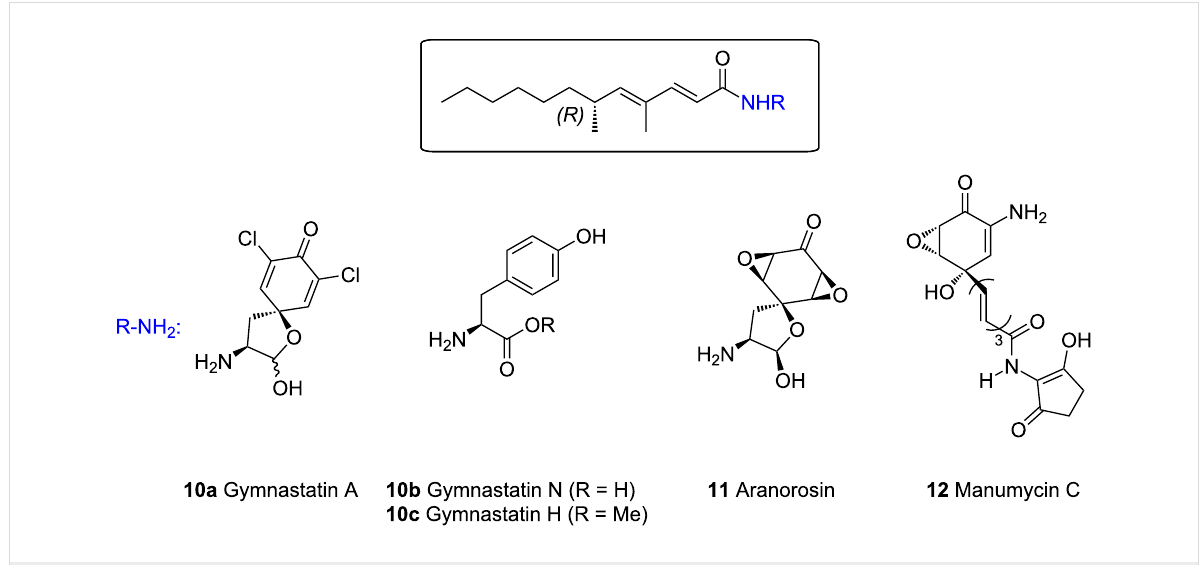
Figure 2: Natural amides possessing the same (6 R )-fatty acid side chain.